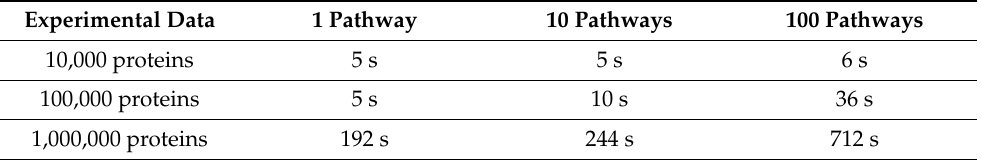
Table 1. Performance test for the ‘Pathway-Calculator’ (details in Section 2.2).